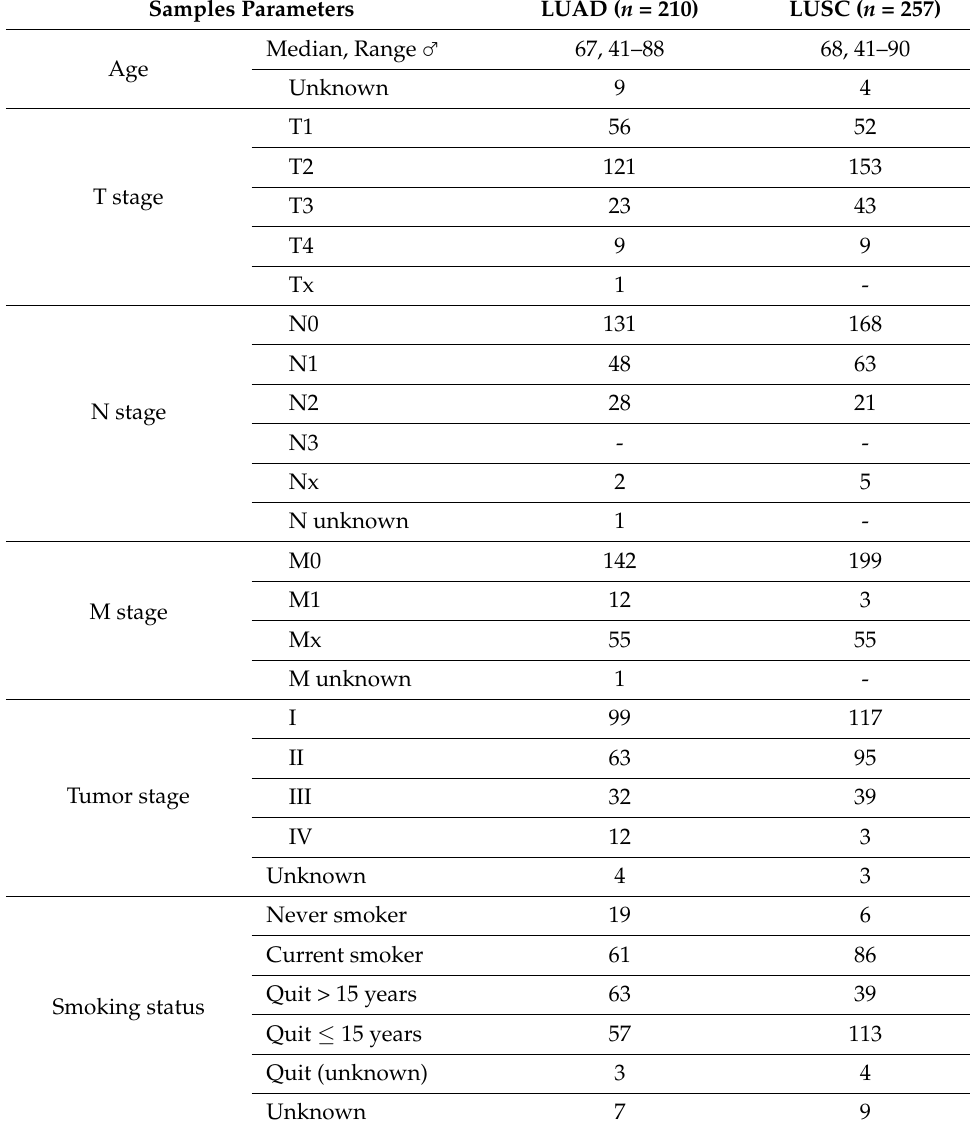
Table 1. Male NSCLC TCGA samples’